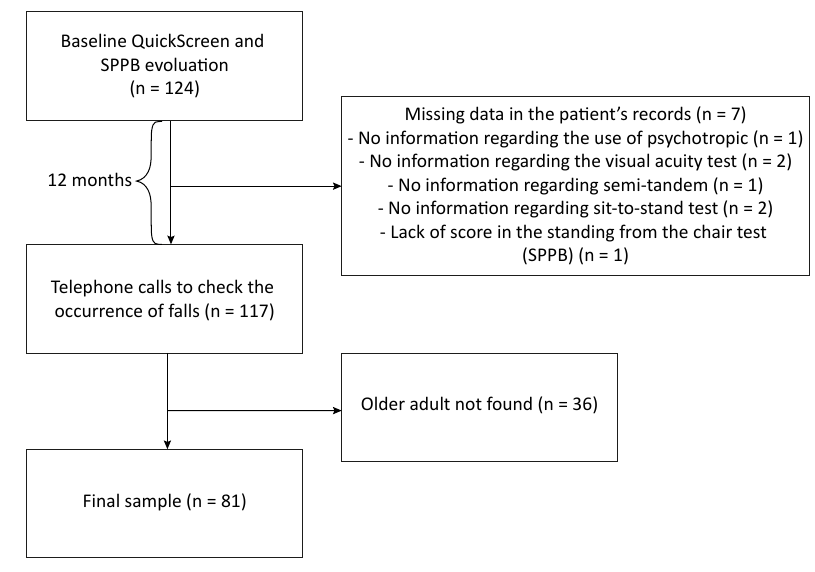
Figure 1 – Sample and research procedure flowchart.